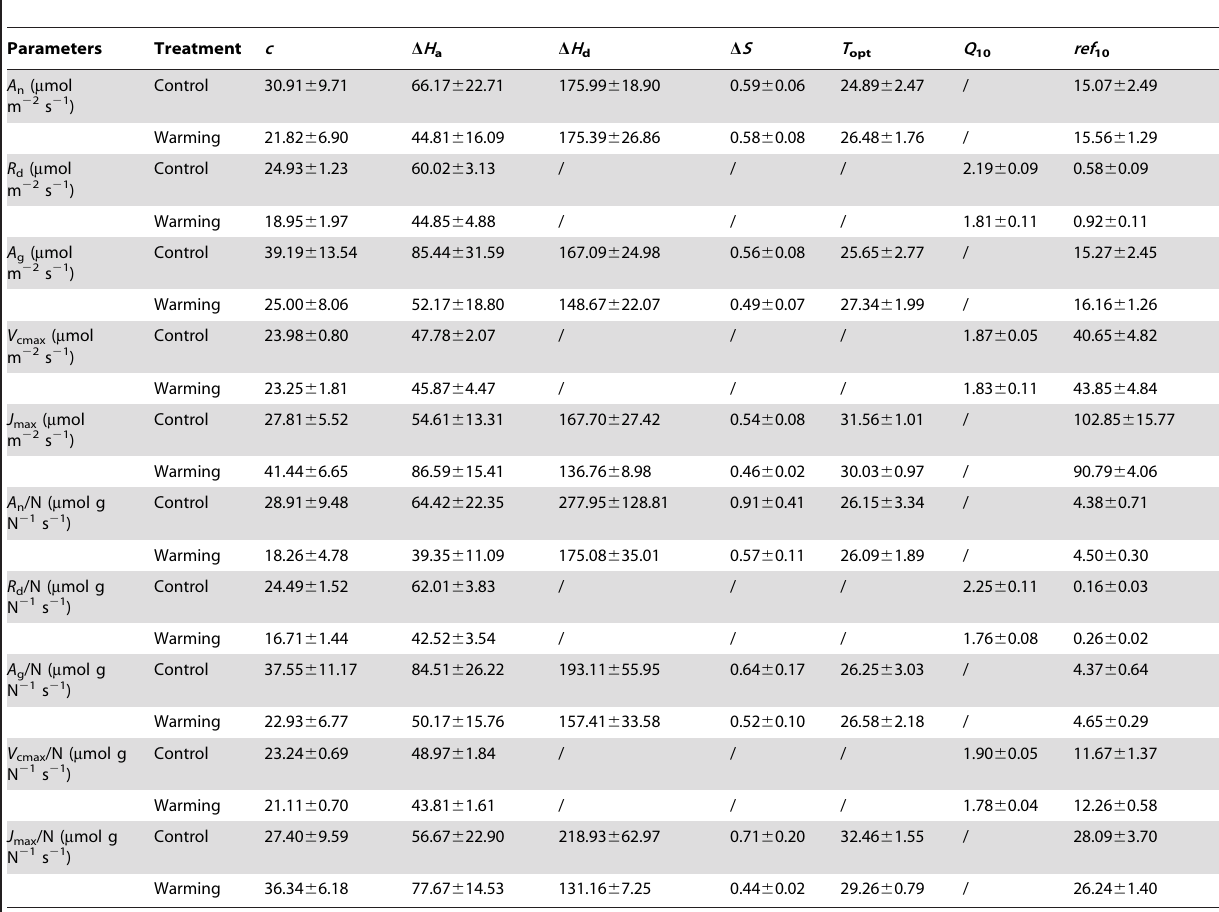
Table 3. Warming effects on the responses of A n , R d , A g , V cmax and J max expressed per unit foliar area and nitrogen to instantaneous change (10–40 u C within a 5 h period) in T leaf in the wet growing season